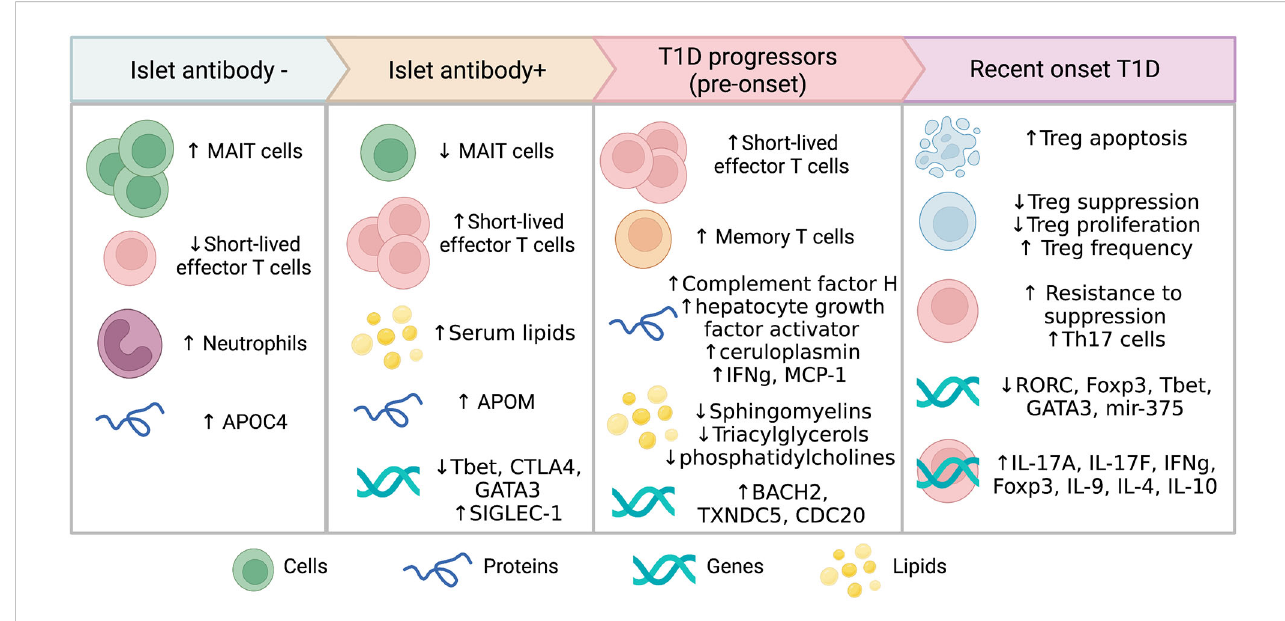
FIGURE 2 Circulating biomarkers associated with different stages of T1D progression.